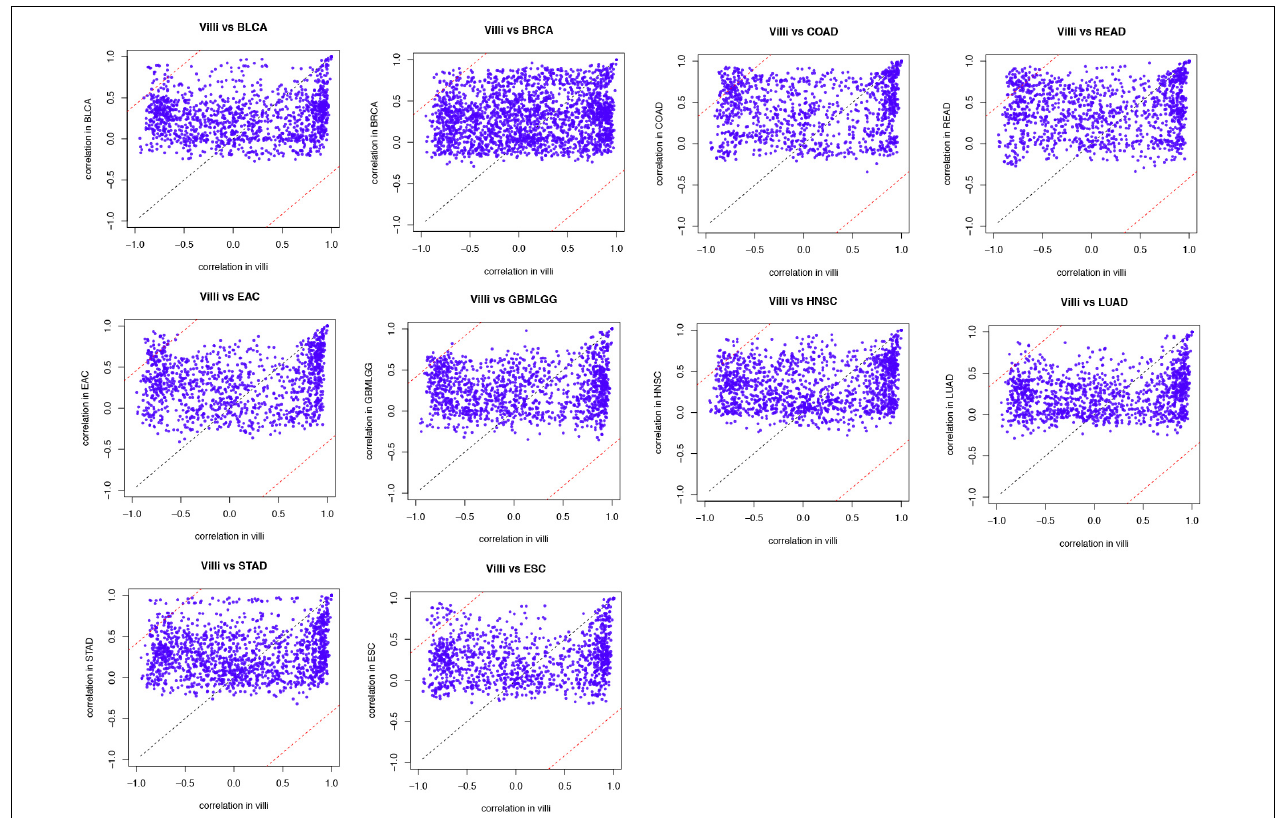
FIGURE 3 | Identified “off-track genes” in villi and tumors. In the biological process of EMT, the interaction between gene pairs in villi and a specific type of cancer was projected on the coordinate axes. The black dotted line in the figure represents the line y = x , and a distance of 1 from this line is shown by the red dotted line.